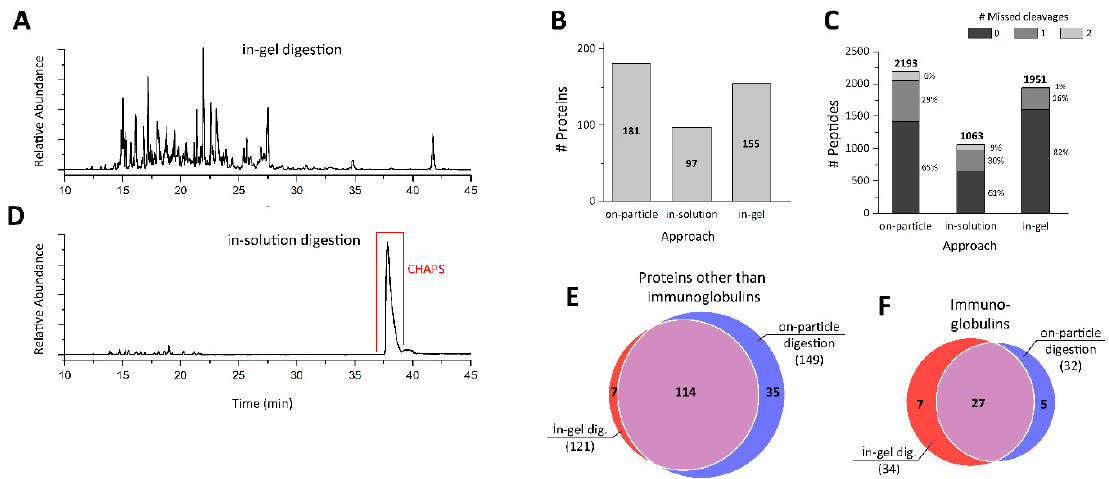
Figure 7. Analysis of SiO 2 NMs protein corona using an in-gel digestion and an in-solution digestion-based approach. Base peak electropherograms of protein corona digested ( A ) in-gel and ( D ) in-solution. The impact of the different sample preparation (corona isolation) procedures on the total numbers of ( B ) proteins and ( C ) peptides identified. Venn diagrams of non-immunoglobulins ( E ) and immunoglobulins ( F ) identified by the on-particle and in-gel approach. All experiments were performed in triplicate.